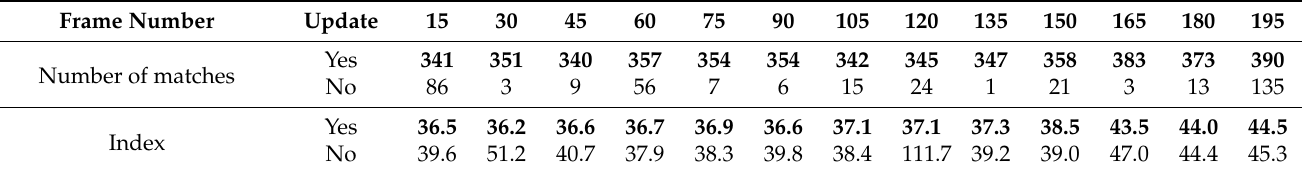
Table 6. Comparison of the number of matching points and index values. The better results are highlighted in